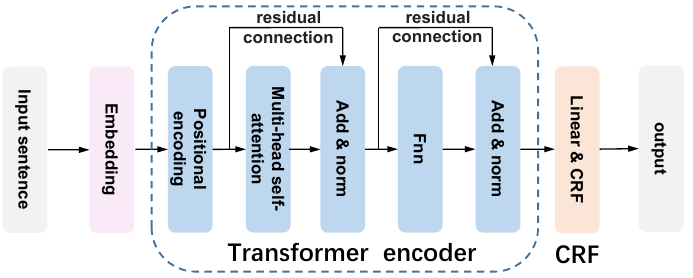
Figure 6. Named entity